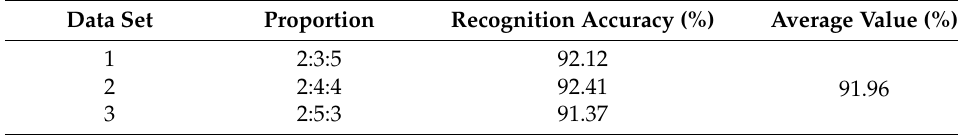
Table 7. The recognition accuracy of the GLCM algorithm.